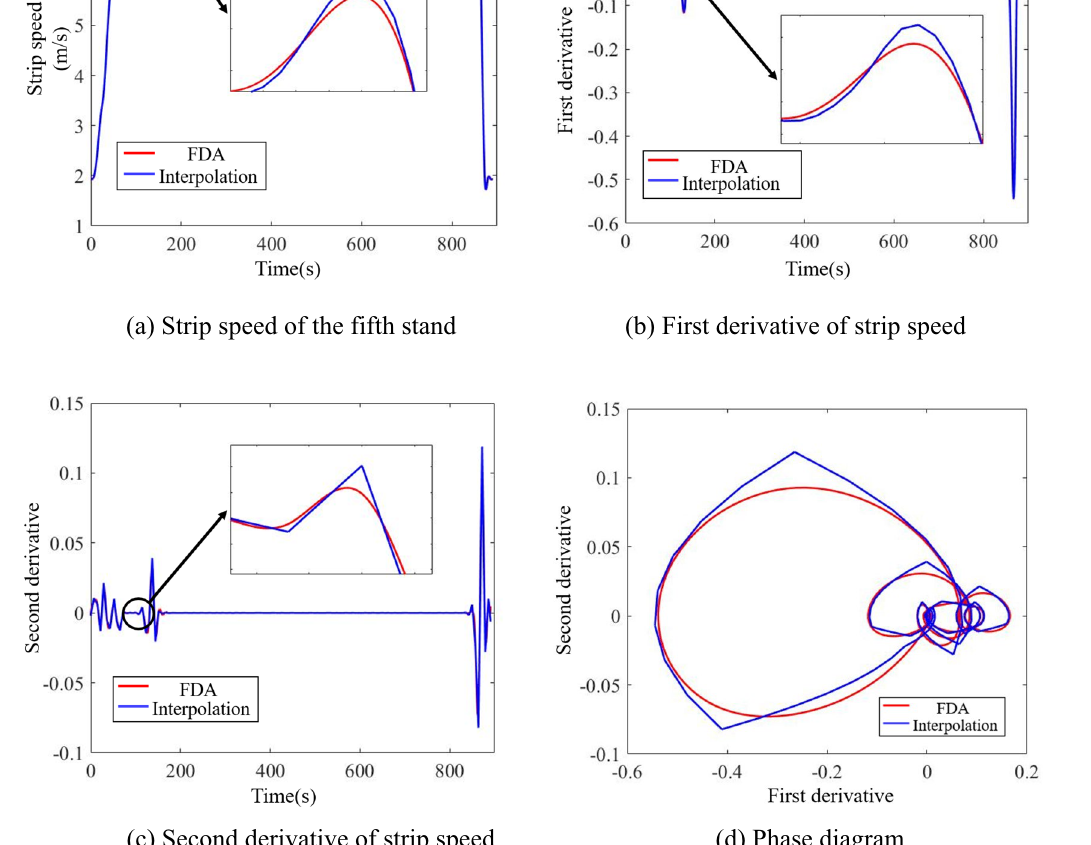
Fig. 4 Data expansion based on Functional Data Analysis method and interpolation method